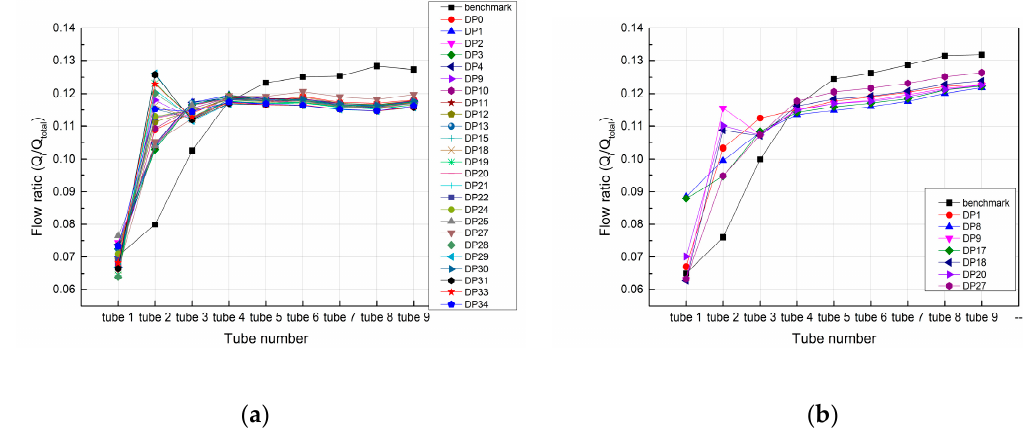
Figure 14. Result comparison between novel designs by parameter changes and the benchmark test model. Flow distribution of each tube in ( a ) U-type and ( b ) Z-type.